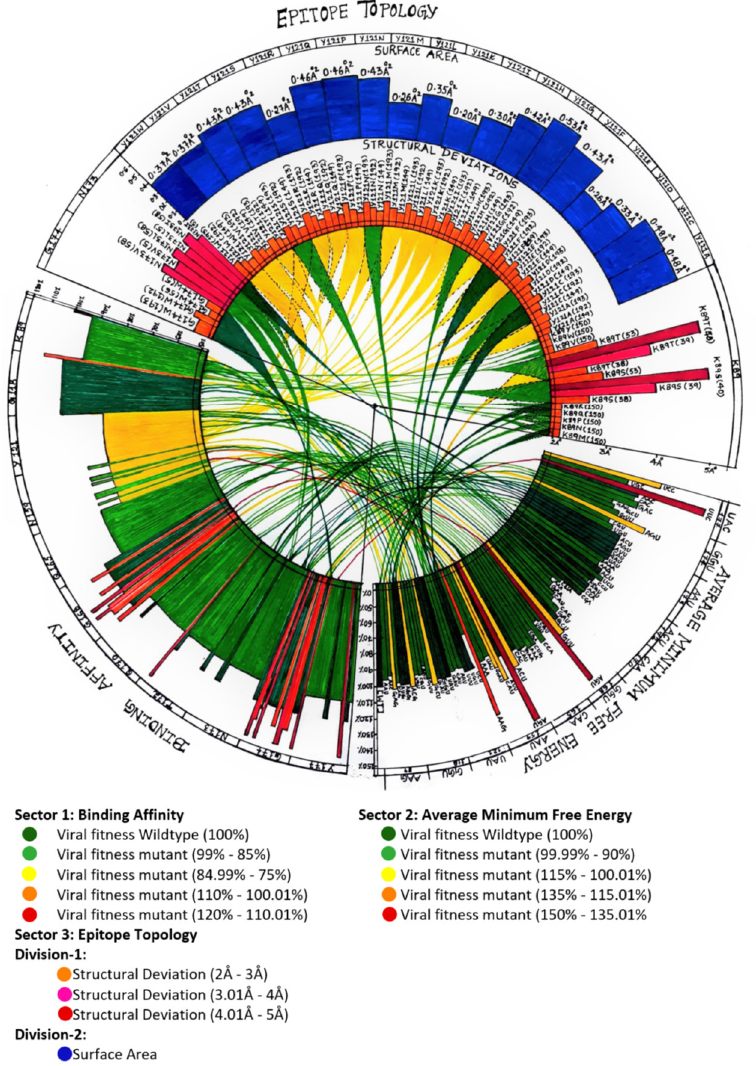
Figure 4. Circular plot correlating mRNA vs. protein parameters. The circular plot shows correla- tion between the mRNA stability and AMFE-based viral fitness ( bottom right sector ) vs. binding affinity-based viral fitness ( bottom left sector ) vs. structural deviations and changes in the epitope topology ( top sector ).